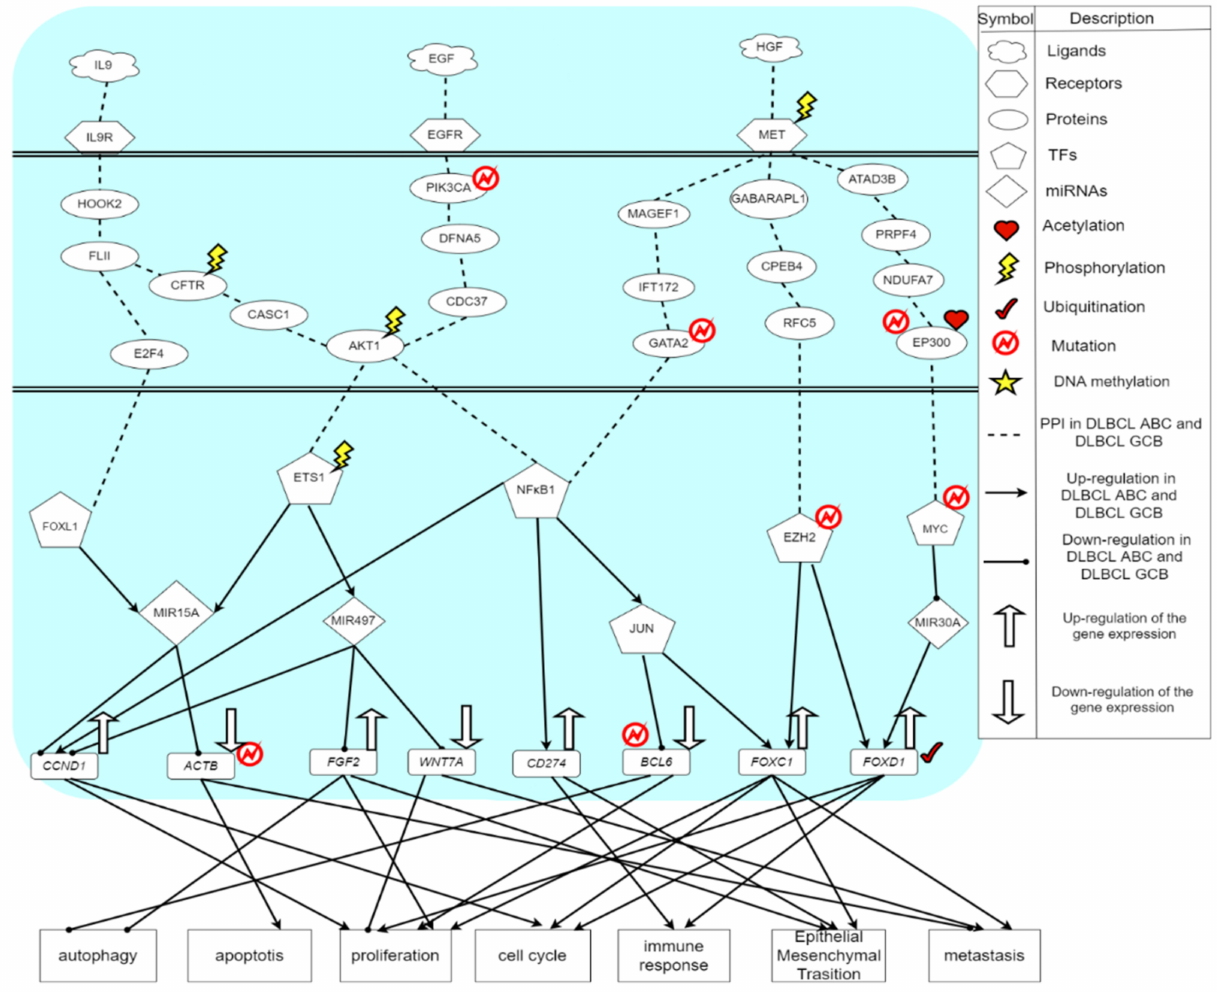
Figure 3. The core signaling pathways of DLBCL GCB: The dotted black line indicates protein–protein interactions of DLBCL GCB; the black arrow head of solid lines means activating cellular functions; the black circle head of solid lines means inhibiting cellular functions; the up arrow on the target gene indicates an up-regulation. The down arrow on the target gene indicates a